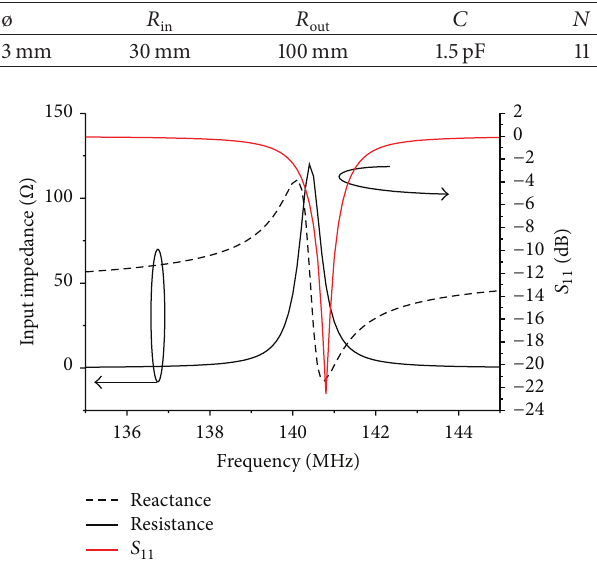
Figure 3: The complex input impedance response and 𝑆 11 reflection coefficient values of proposed antenna for WPT against frequency. The reflection coefficient values are obtained using a 𝑍 ch = 50 Ω transmission line feed.